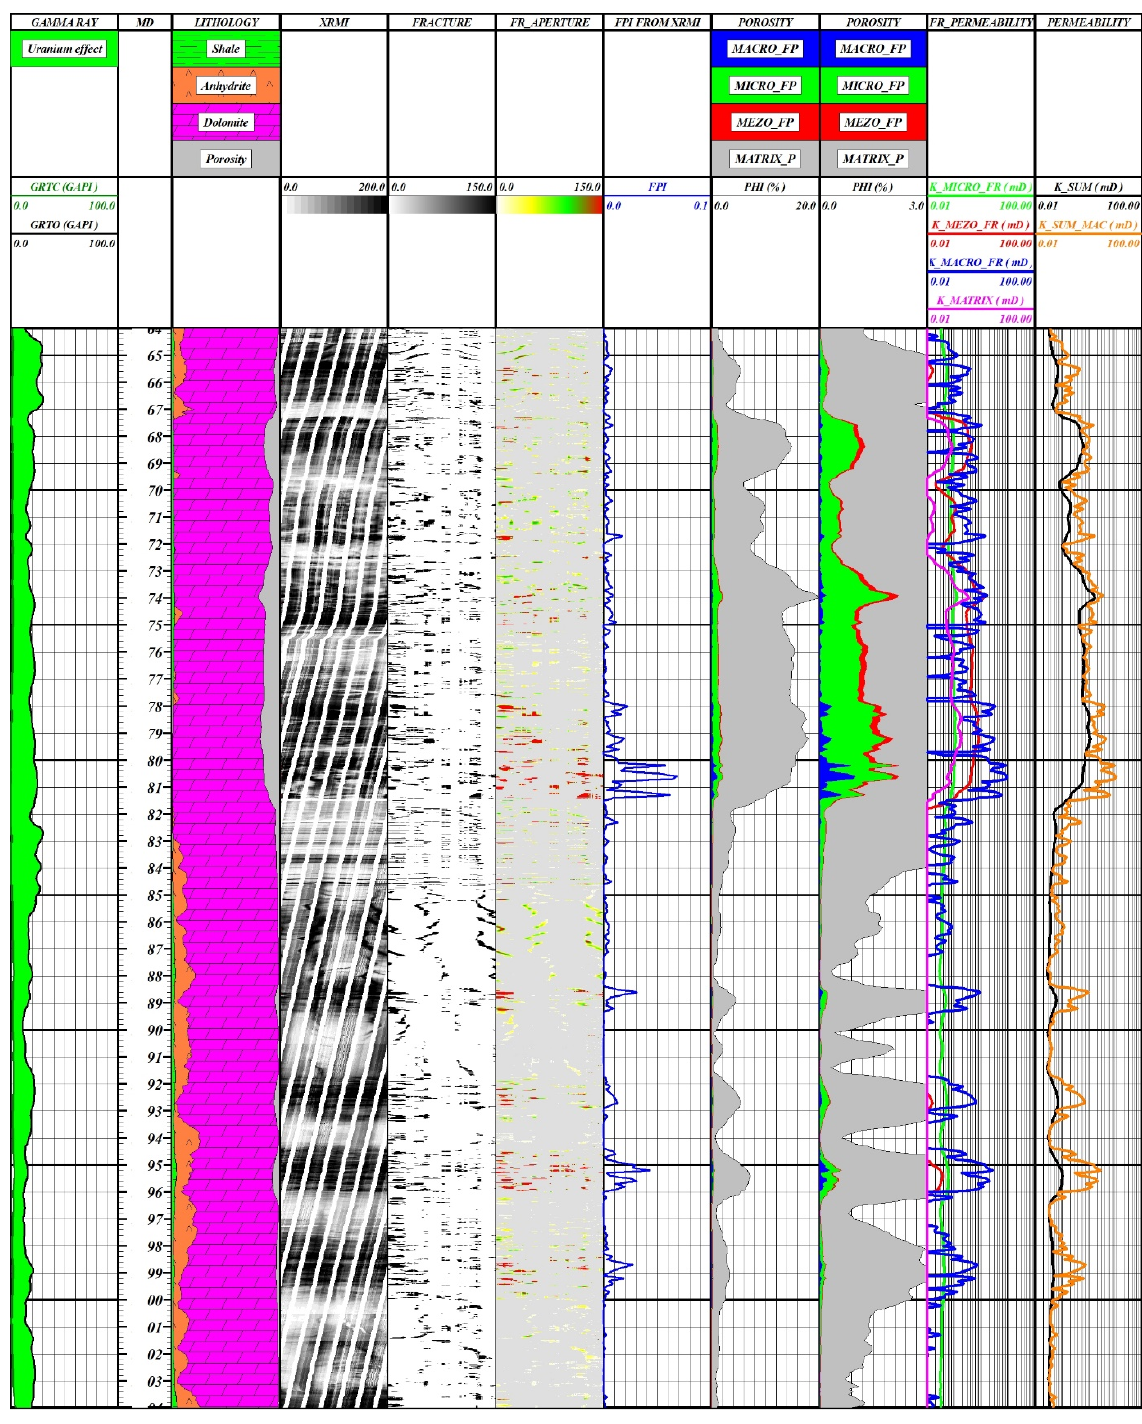
Figure 13. Results of the permeability and porosity analysis (taking into account micro-, mezzo- and macrofractures in the Main Dolomite, Ca2, G-10 borehole; symbols as in Figure 1).